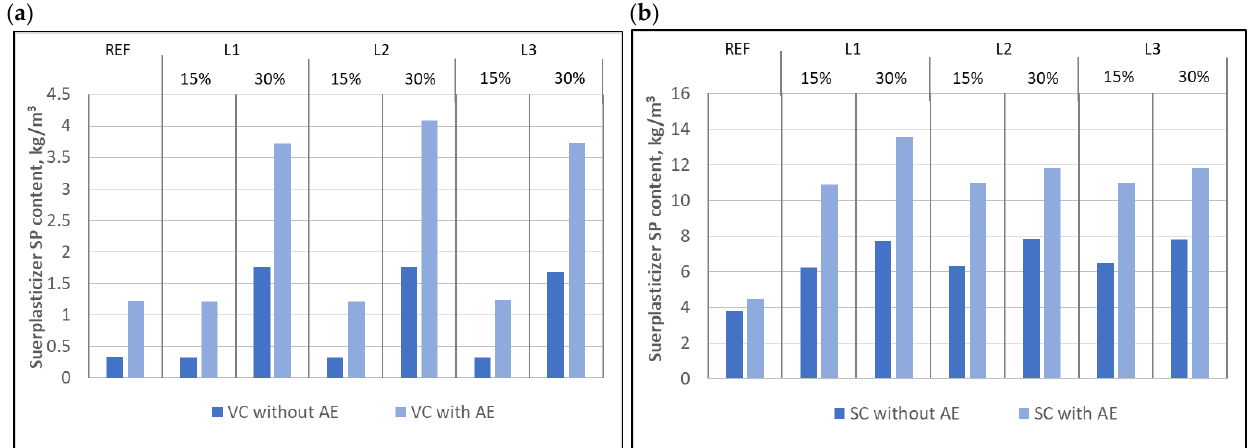
Figure 3. Superplasticizer amount for ( a ) vibrated concrete, ( b ) self-compacting concrete.